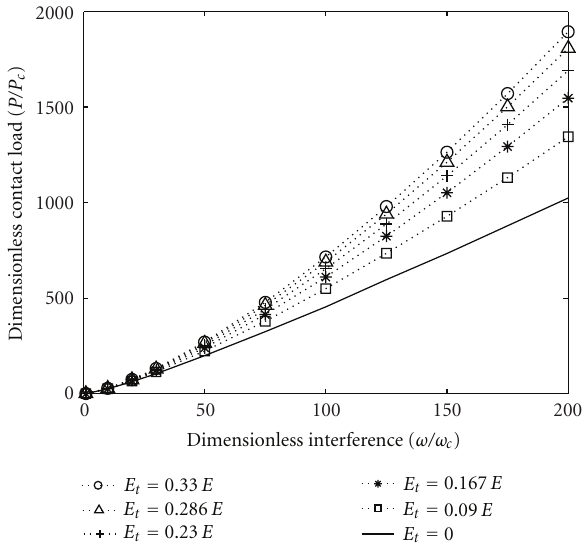
Figure 5: Dimensionless contact load versus dimensionless inter- ference at stick contact condition.